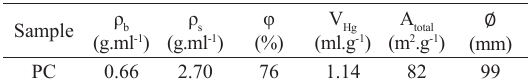
Table 2. Textural properties of PC from mercury porosimetry: bulk density ( ρ ); skeletal density ( ρ ); porosity ( φ ); total volume of pores b s ( V ); total pore area ( A ) and pore diameter ( Hg total